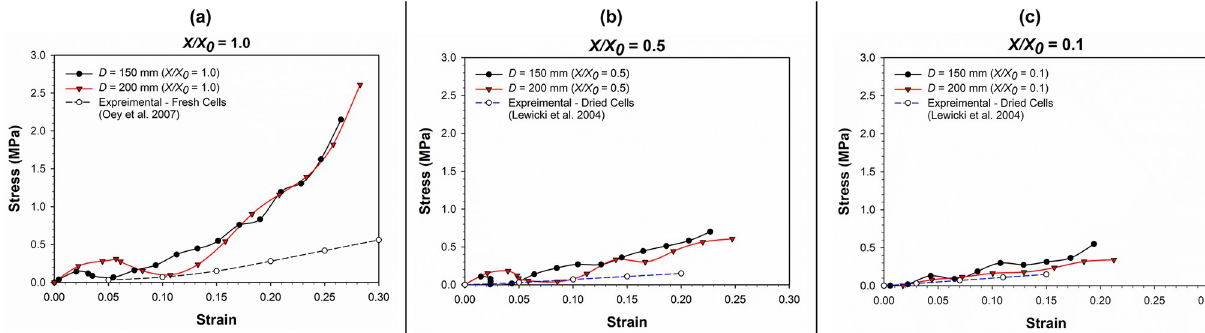
Fig 18. The stress-strain relationship of cells as affected by different cell sizes. (a) fresh cells ( X/X extremely dried cells ( X/X 0 = 0.1) ( D is the cell diameter and X/X 0 is the normalised moisture content).